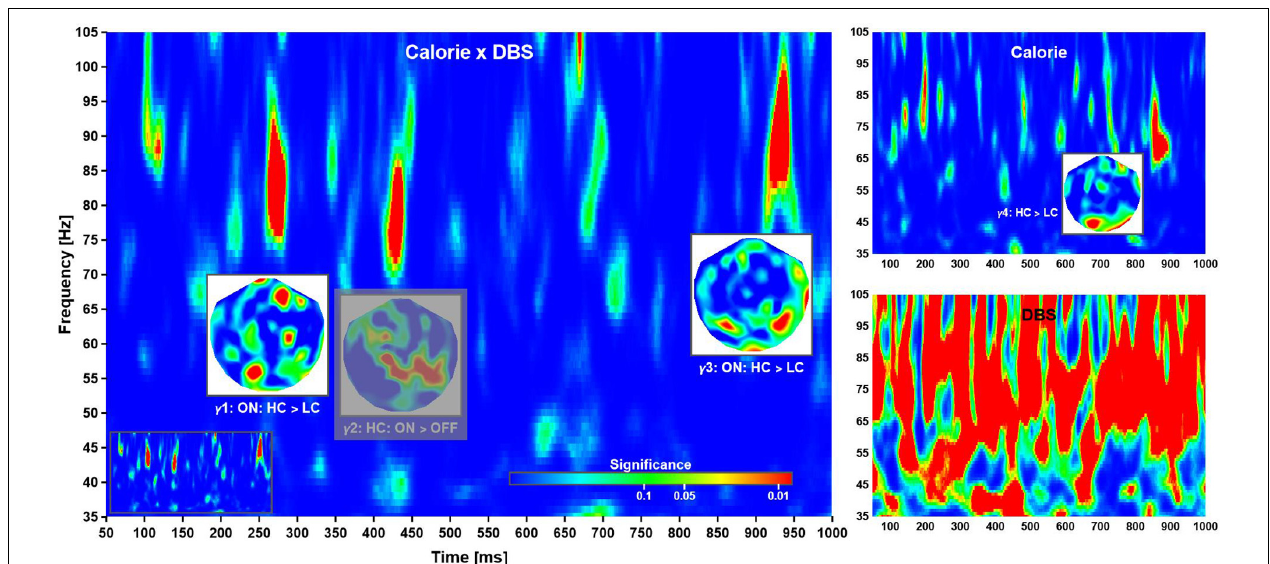
FIGURE 4 | Time-frequency planes. Phase-locking in the high γ -band was modulated by a Calorie × DBS interaction (left), as well DBS (bottom right) and Calorie effects (top right). The insets show the distributions of significance over head for each cluster, where all significant regions within a cluster corresponds to a difference in phase-locking as indicated (at grand-mean level; phase-locking values not shown). The phase-locking indicates time-dependent neuronal networks: anterior-to-posterior, mainly parietal, and mainly occipital. The clusters locate at γ 1: 260–285 ms, 75–92 Hz; γ 2: 420–440 ms, 71–86 Hz; γ 3: 918–945 ms, 83–100 Hz; and γ 4: 850–895 ms, 64–83 Hz. Note that γ 2 (grayed out) was not further considered (see text for explanation). Also note that deep brain stimulation had a strong influence on phase-locking, thereby rendering the corresponding plane uninterpretable. For completeness, the time-frequency plane of Calorie × DBS significance without overlays is shown as an inset (bottom left).